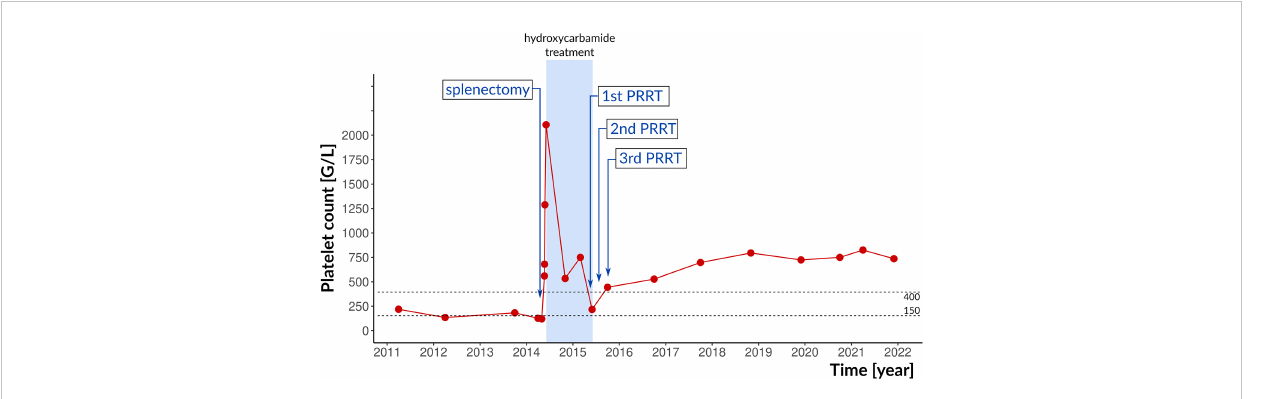
FIGURE 1 Therapeutic interventions and platelet counts. The reference range is indicated by dotted lines. PRRT, peptide radioreceptor